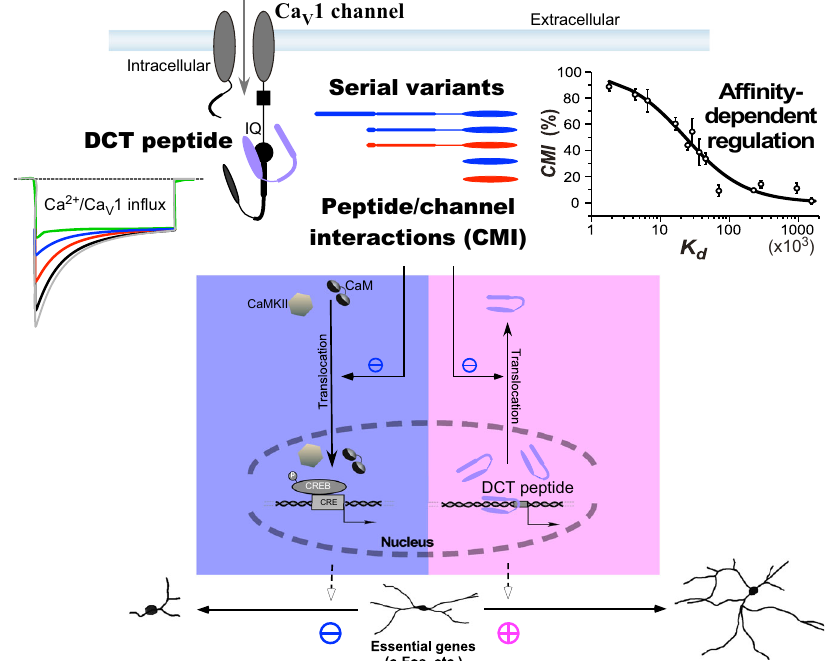
Fig. 8 Cytosolic DCT peptides regulate Ca V 1 channel- and nuclear DCT-mediated neuritogenesis. Regardless of the distinctions in mechanisms of production, molecular compositions, or modulatory effects, diverse peptides have been uni fi ed into a tuning curve of the central principle: DCT/Ca V 1 af fi nity-dependent inhibition of the channel activity-neuritogenesis coupling, which has been demonstrated by representative Ca V 1.3 channels in cortical neurons. A series of DCT peptide variants (color-coded to illustrate the difference in origin), by interacting with Ca V 1 channels, inhibit Ca 2 + in fl ux (color- coded to illustrate the difference in potency) and regulate Ca V 1 signaling to the nucleus and gene expression, all quantitatively in accordance with peptide/ channel af fi nity ( CMI-K d relationship). For Ca V 1 channel bound with CaM at the preIQ-IQ domain, cytosolic DCT peptides compete against CaM to form peptide-channel complex. The capability of DCT competition is quanti fi ed as CMI potency to represent the fraction of channels being switched from CaM- bound to DCT-bound. DCT-channel af fi nities or CMI potencies are drastically different among serial peptide variants including those endogenous to native cells, varying in size (long, medium or short) and/or origin (Ca V 1.1-1.4). In close correlation with CMI potency, DCT peptides inhibit Ca V 1 gating and Ca 2 + in fl ux, reduce nuclear translocation of key signaling molecules CaM (and CaMKII), and attenuate Ca V 1-mediated transcription (e.g., pCREB) and expression of essential genes (e.g., c-Fos), eventually leading to inhibition of neuritogenesis (in the blue shade). As collateral effects (in the pink shade), CMI also downregulates nuclear export of DCT peptides, and thus facilitates gene transcription directly mediated by nuclear DCT peptides, leading to promotion of neurite arborization and extension. In summary, we discover cytosolic DCT inhibition of the Ca V 1 activity-neuritogenesis coupling, which is in direct opposition to neurotrophic signaling of nuclear